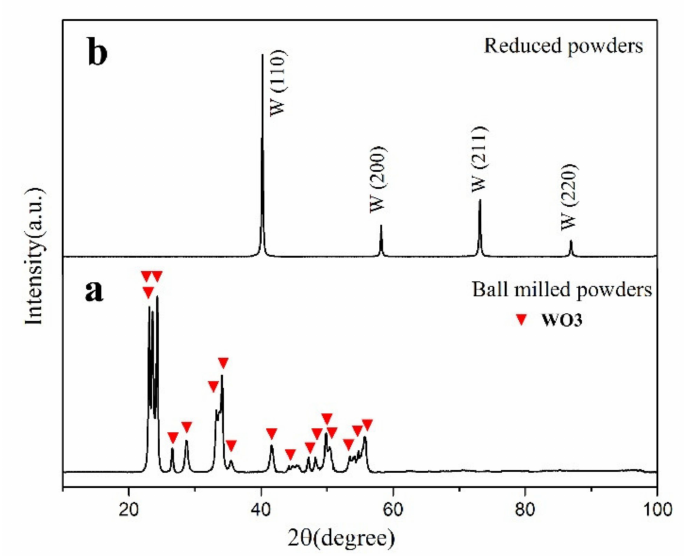
Figure 4. XRD patterns of the ( a ) ball-milled and ( b ) reduced powders.